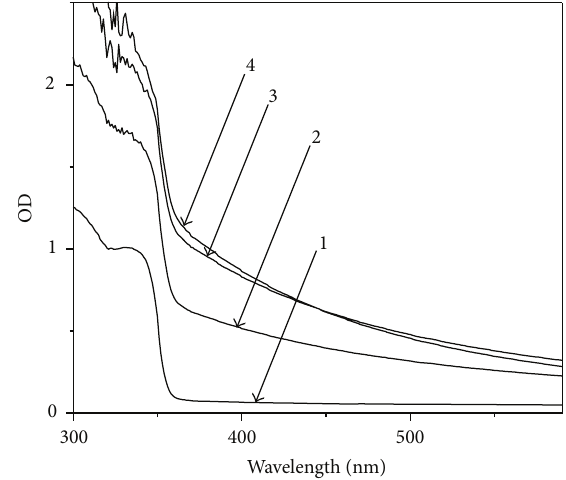
Figure 1: The absorption spectra of colloidal solutions of ZnO nanoparticles without SiO 2 (1) and in the presence of 0.25 g (2), 0.625 g (3), and 1.25g of silica (4) in 10mL of zinc oxide solution. [ZnO] = 2 × 10 −2 mol/L, 𝑙 = 0.1 cm.